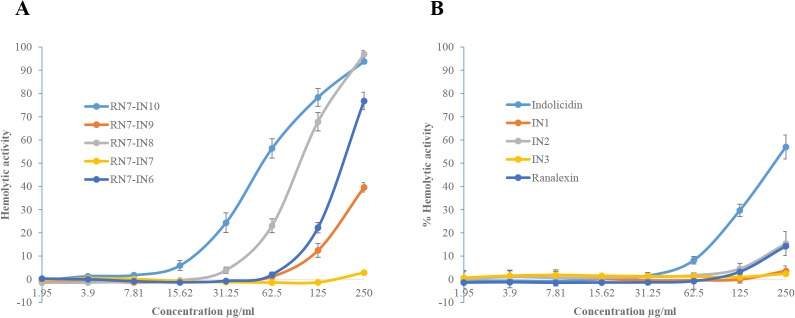
Hemolytic activity against human erythrocytes.Hemolytic activity of synthetic peptides against human erythrocytes. Hemolytic effect of hybrid peptides (A) and indolicidin and its analogs (B). Hemolysis was determined by measuring hemoglobin absorbance at 560 nm in the supernatant presented as percentage hemolysis achieved with 0.1% Triton X-100.